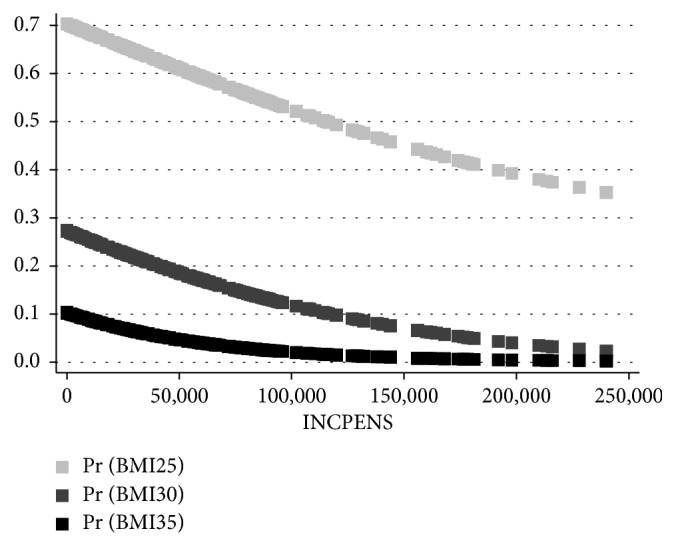
Relationship between the projected probability of Overweight (BMI ≥ 25), Type I (BMI ≥ 30), and Type II obesity (BMI ≥ 35) and annual gross income from pension among females above 67 years. Note. The figure describes the projected probabilities obtained from the probit model, where the dependent variables are BMI25, BMI30, BMI35, dummy variables, which equal one for Overweight (BMI ≥ 25), Type I (BMI ≥ 30), and Type II obesity (BMI ≥ 35) and zero otherwise. The independent variable is INCPENS, the annual gross monetary income from pensions measured in NIS (the local Israeli currency, 1 NIS ≈ $0.25), which refers to the 40.1% (59.9%) of the 921 female respondents above 67 years who got pension (without pension). We excluded a few outliers for which INCPES > 250,000. For women, the respective Pearson correlations between BMI25, BMI30, BMI35, and INCPENS (−13.90%, −13.55%, −10.01%) are negative and different from zero correlation (p < 0.0001, p < 0.0001, and p=0.0024, respectively). The Pearson correlations between BMI25, BMI30, BMI35, and INCPENS among the 869 male respondents were found to be equal to zero (p=0.5016, p=0.5680, and p=0.0530, respectively).